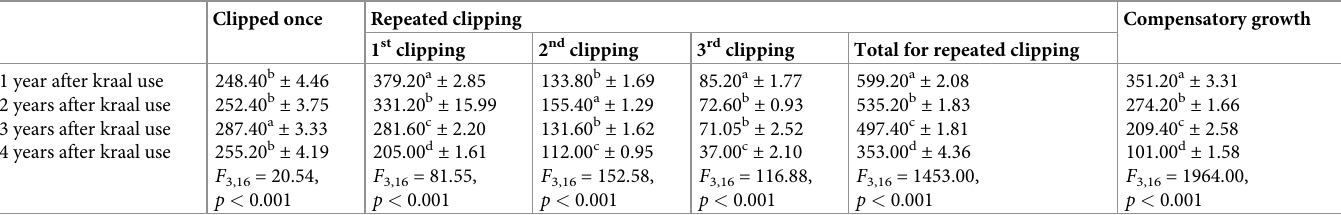
Table 1. Mean ( ± SE) aboveground grass biomass (gm -2 ) in cages clipped once and repeatedly (three times) in previously kraaled sites of different ages. Clipped